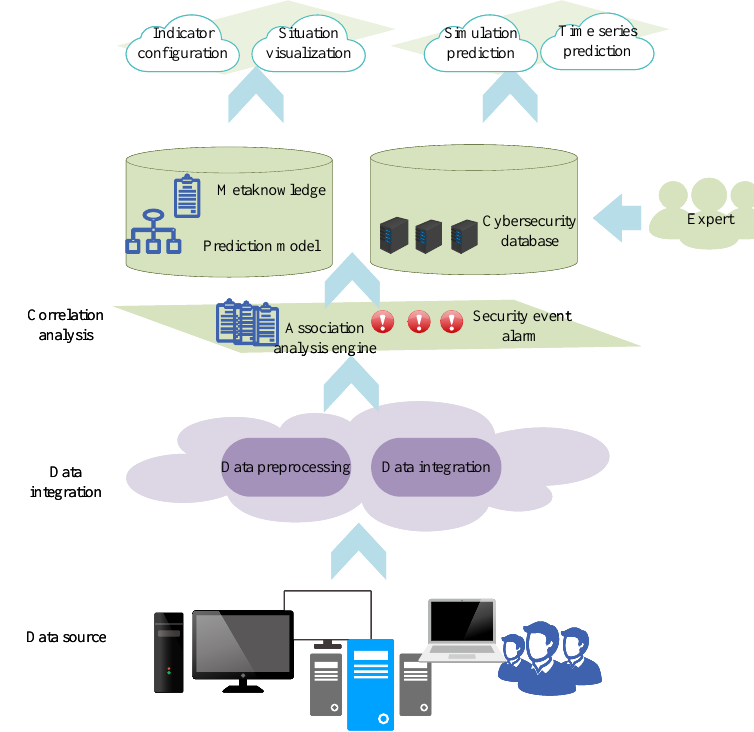
Figure 4. NSSA model for large-scale